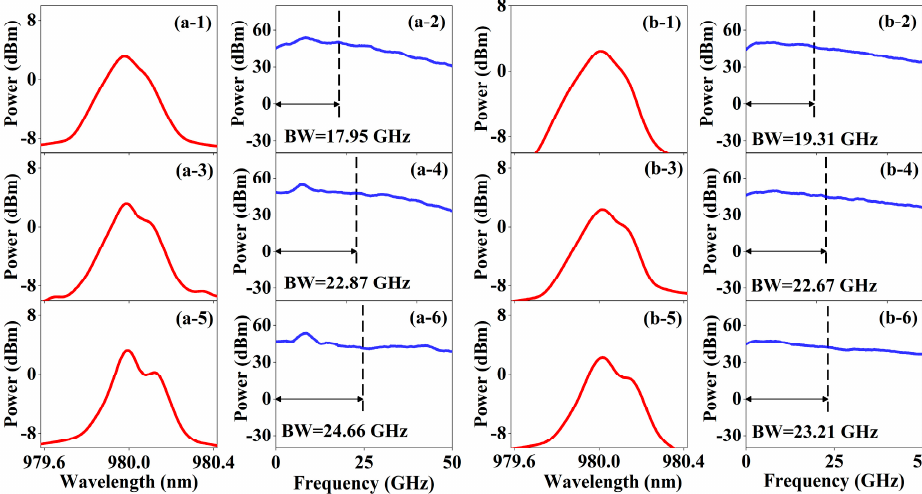
Figure 4. The optical spectra and frequency spectra of the ( a-1 – a-6 ) XP mode and ( b-1 – b-6 ) YP mode of the VCSEL1. ( a-1 , a-2 ) and ( b-1 , b-2 ) k inj = 50 ns − 1 and ∆ f = 20 GHz; ( a-3 , a-4 ) and ( b-3 , b-4 ) k inj = 50 ns − 1 and Δ f = 30 GHz; ( a-5 , a-6 ) and ( b-5 , b-6 ) k inj = 50 ns − 1 and Δ f = 40 GHz.